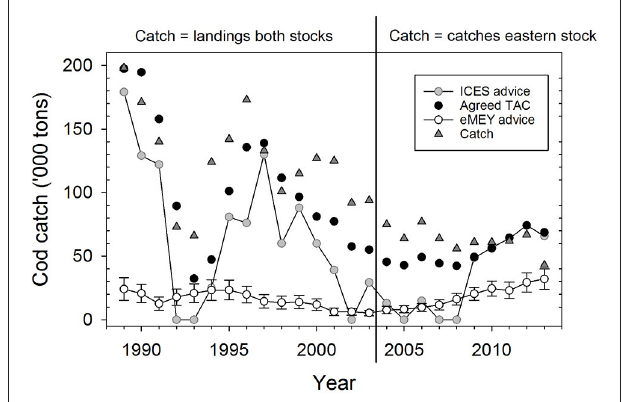
FIGURE 1 | Time-series of ecologically-constrained MEY (eMEY; 10 years time perspective), ICES advice, politically agreed TAC, as well as actual catches for the Eastern Baltic cod fishery. Up to 2003 a common TAC was set for the Eastern and the Western Baltic cod stocks; we westimate the TAC for the eastern stock only, based on the biomass ratio of both stock components. Error bars on eMEY estimates show the results of a sensitivity analysis concerning economic model